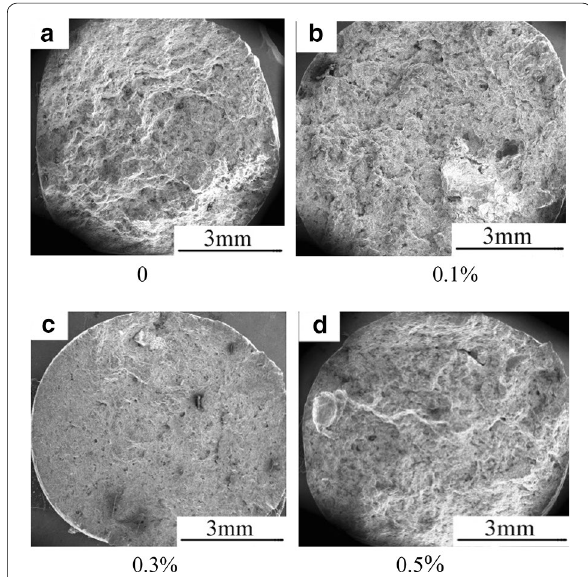
Figure 3 Macro‑fracture structure of heat‑treated alloy with the addition of different Y